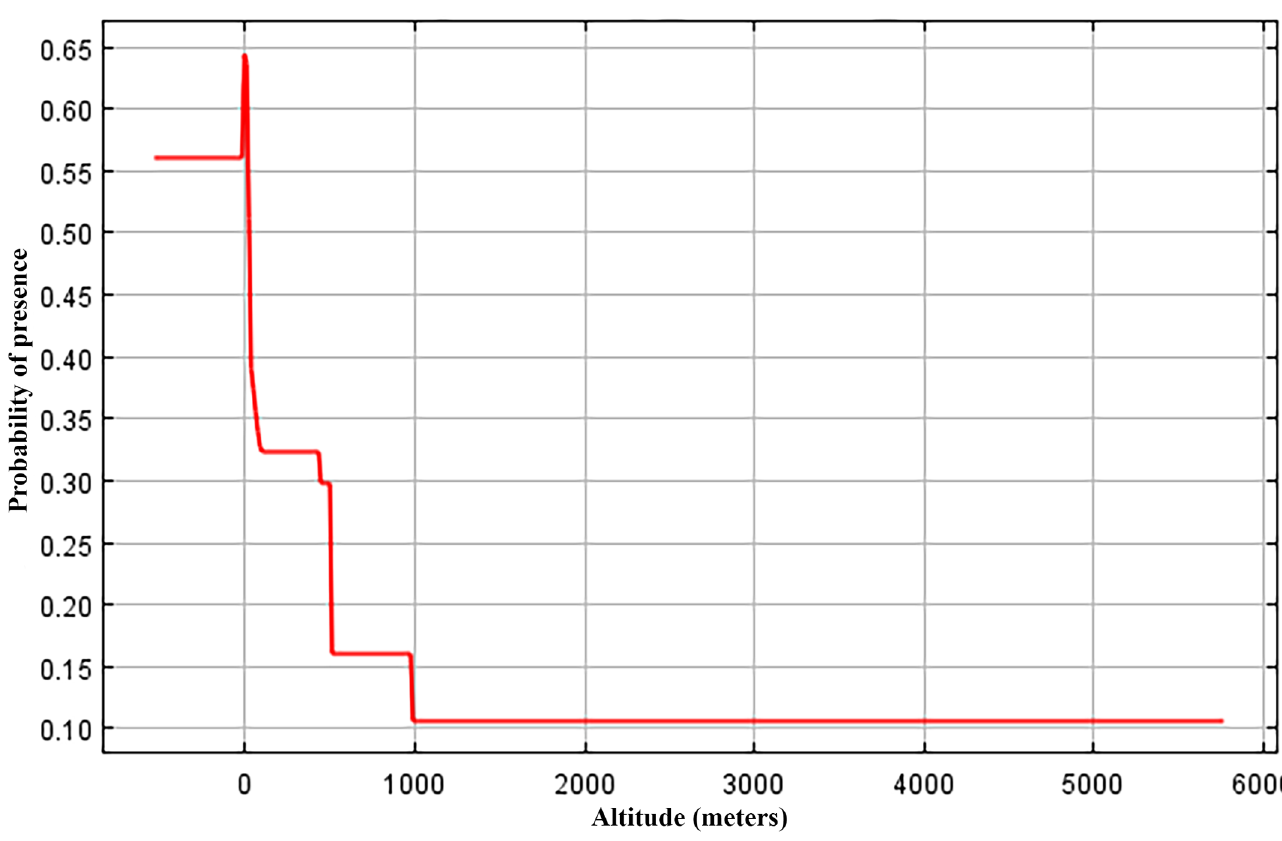
Fig 4. Graph showing probability of presencebased on altitude (in meters)generated in ecological niche models for Vieja maculicauda .